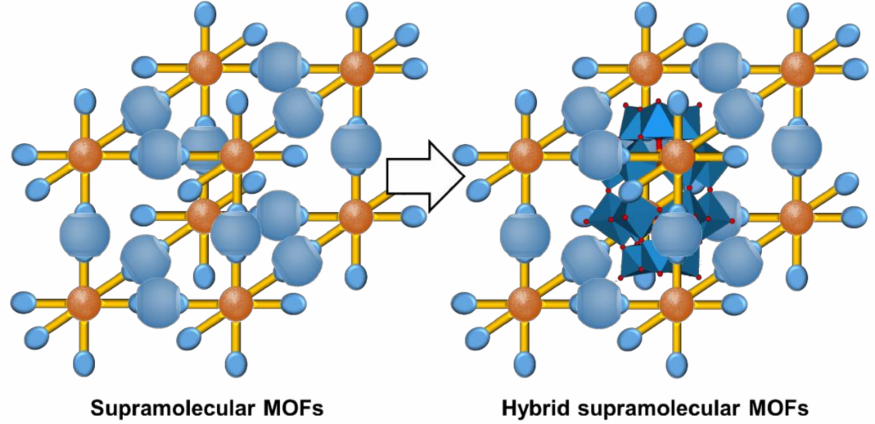
Figure 52. The formation of a hybrid assembly obtained after [P 2 W 18 O 62 ] 6 − encapsulation inside the cavities of supramolecular metal–organic frameworks.